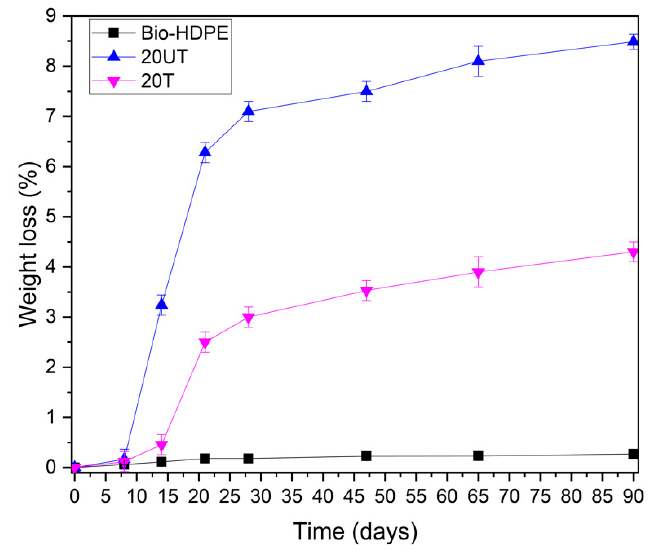
Figure 5. Weight loss of bio-based high-density polyethylene (Bio-HDPE) with 20 wt.% of untreated (20UT) and treated (20T) chia seed flour.